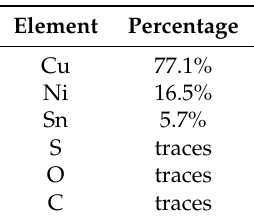
Table 1. Chemical composition of the alloy.